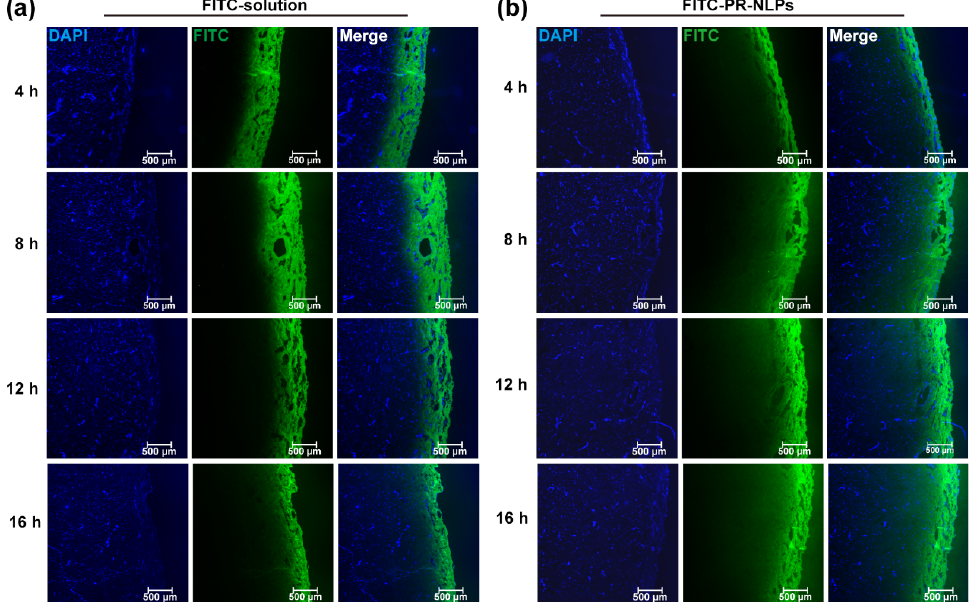
Figure 11. Fluorescence microscope images of the pork skin permeation of ( a ) FITC solution, ( b ) FITC-PR-NLPs. The vertical skin sections with a thickness of 10 μ m were made with cryotome and observed under a fluorescence microscope for skin-associated fluorescence. Scale bar = 500 μ m.